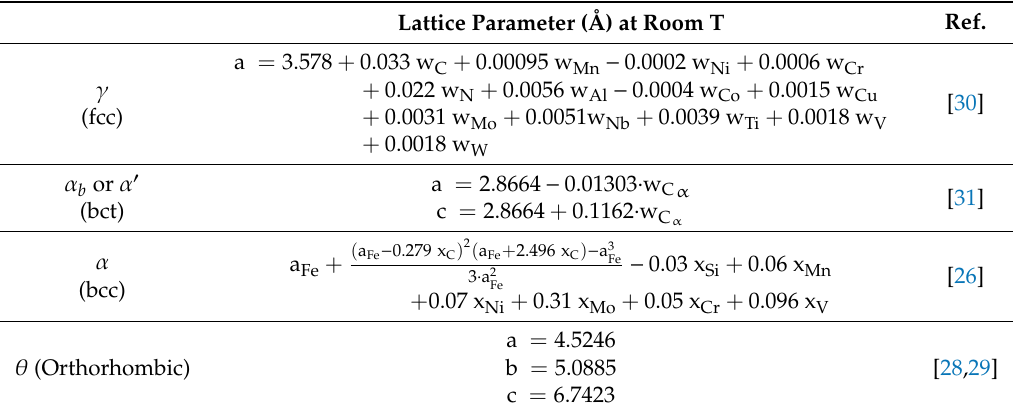
Table 3. Theoretical lattice parameters of the di ff erent phases at room temperature, where w is the concentration in weight%, x in mole fraction and a Fe = 2.88664 is the lattice parameter of pure ferrite. Lattice Parameter (Å) at Room T